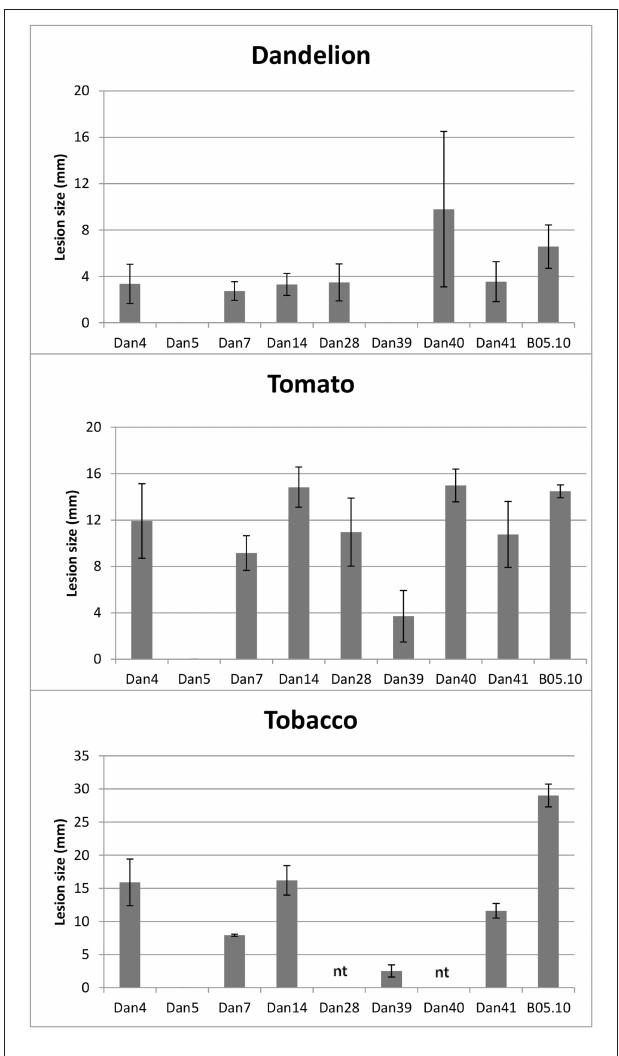
FIGURE 4 | Lesion diameter on leaves of Taraxacum officinale at 5 days after inoculation ( N = 6 ), tomato at 3 days after inoculation ( N = 8 ) and N. benthamiana at 3 days after inoculation ( N = 3 ), following inoculation with Botrytis isolates or B. cinerea strain B05.10. Data presented are means with standard deviations indicated with the error bars.